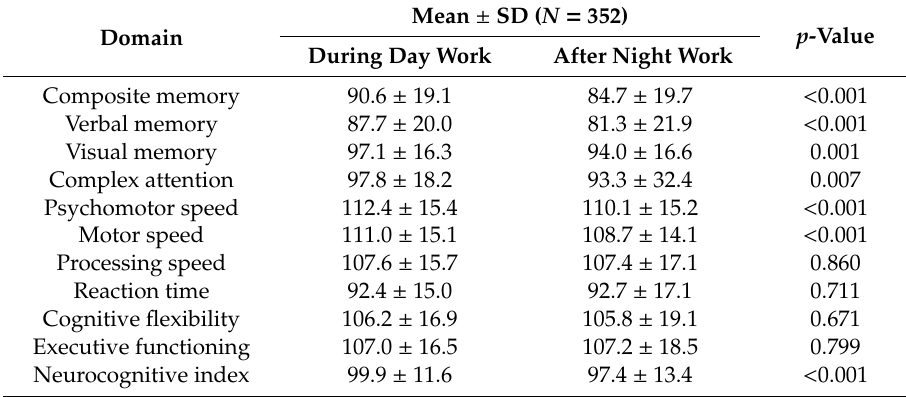
Table 2. Comparison of the neurocognitive function during the daytime work and after the night shift work of firefighters.